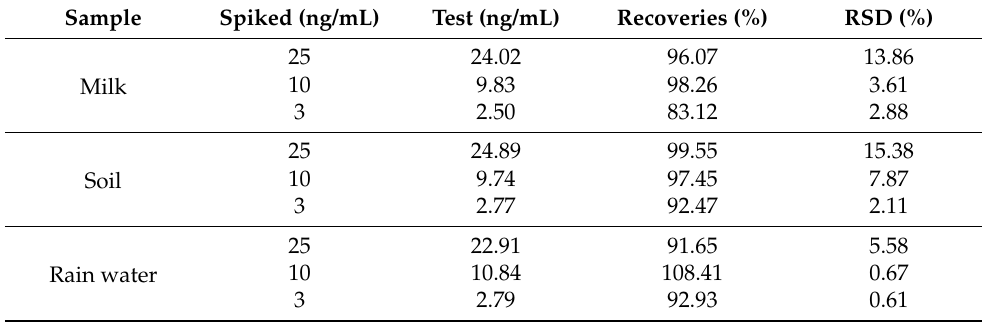
Table 3. Detection of T-2 toxin in real